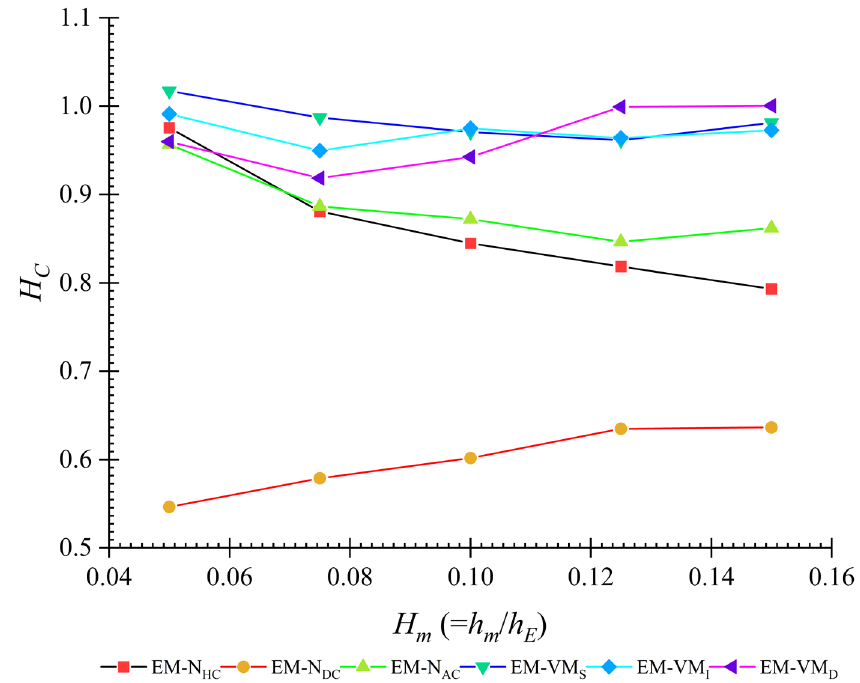
Figure 6. Variation of normalized critical depth ( H c ) with normalized overtopping depth ( H m